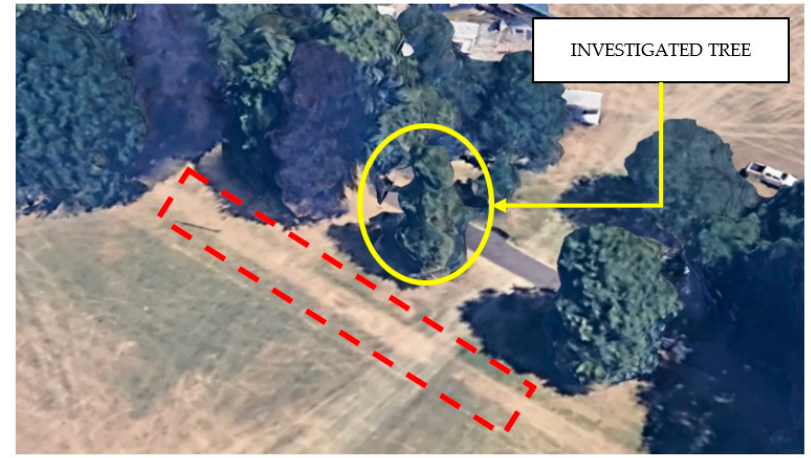
Figure 10. Aerial view of the investigated area. The red dashed area highlights a difference in the ground appearance matching the identified location of the discontinuity feature.